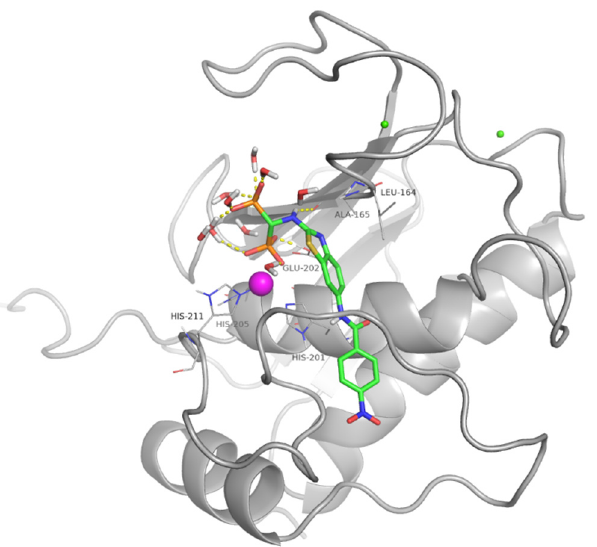
Figure 3. Docked pose of compound 7 (stick, green C atoms) in the MMP-13 binding site (grey cartoon). Most relevant residues are represented as lines and H-bonds are represented by yellow dashed lined.